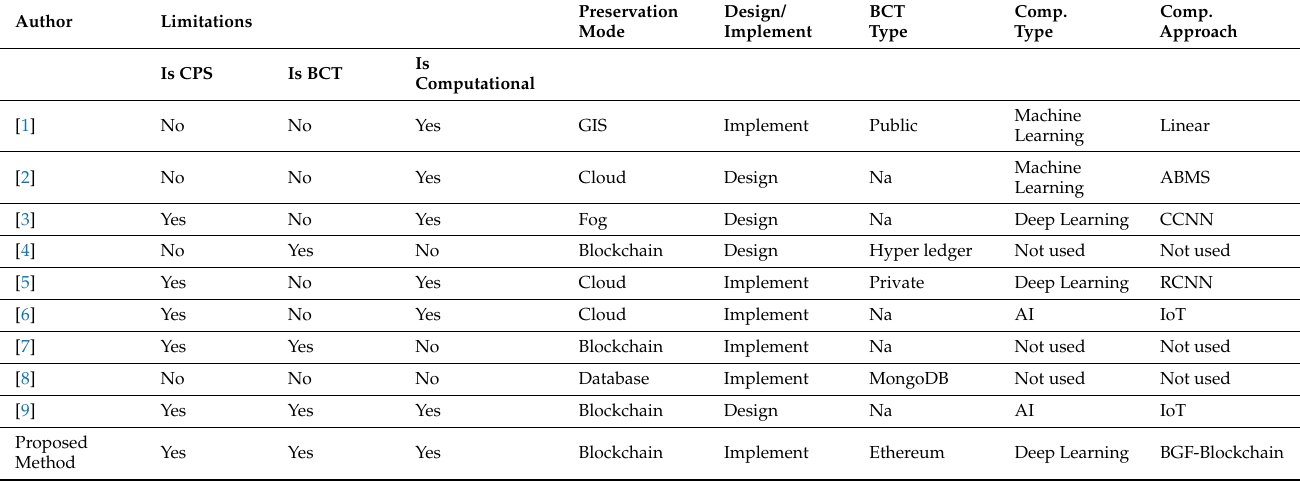
Table 1. Summary of Literature